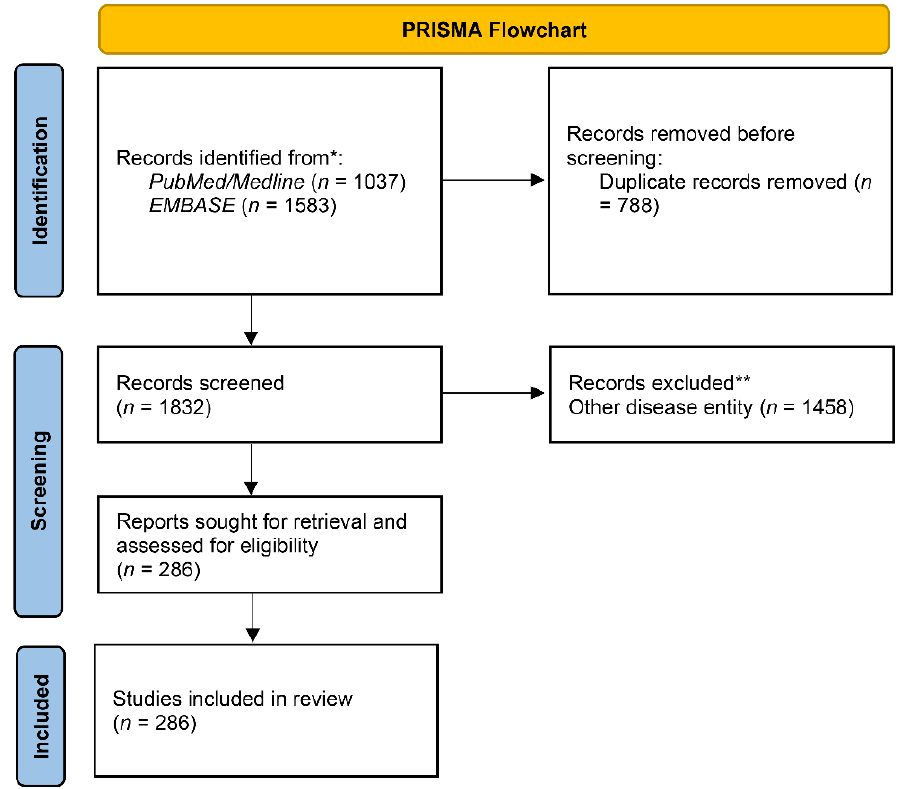
Figure 1. PRISMA 2020 flow diagram visually summarizes the screening process followed in the present